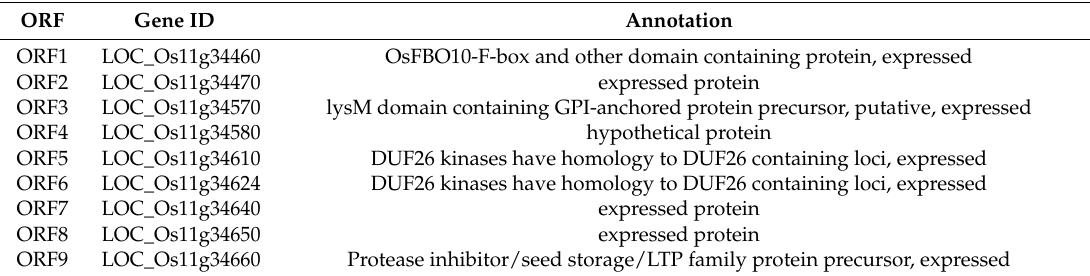
Table 3. The annotation of candidate